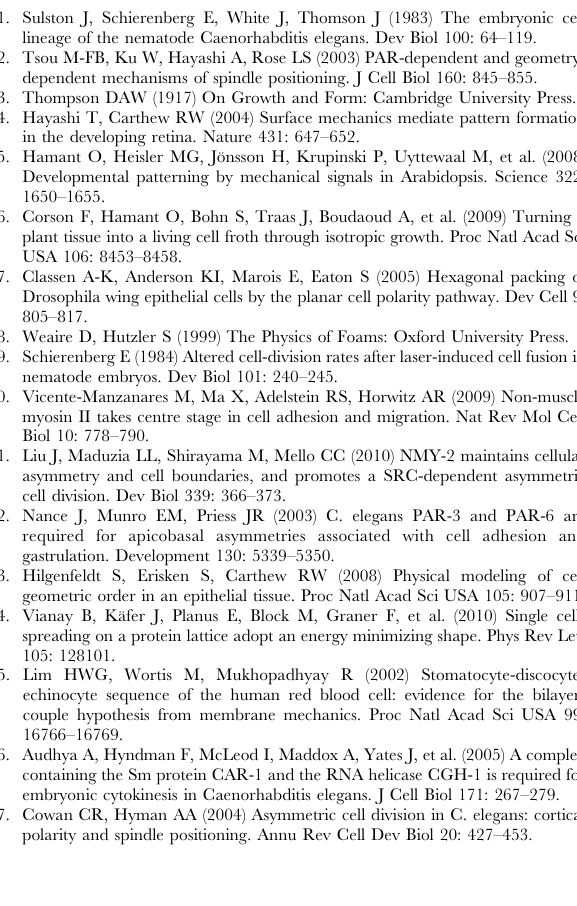
Figure S1 A flow chart of parameter optimization. Our procedure for finding the surface tension parameters that makes the model shape most similar to the target cell shape. The input is a stack of non-time-lapse 2D images of GFP::PH embryos. Red, the eggshell; green, the plasma membranes or their computation- ally extracted contours; orange, the legitimate region in the search space; magenta, model surfaces; dotted, an ellipsoid of least- squares fit to the eggshell contour. (TIF) Video S1 Time-lapse movie of laser-induced cell fusion before curve